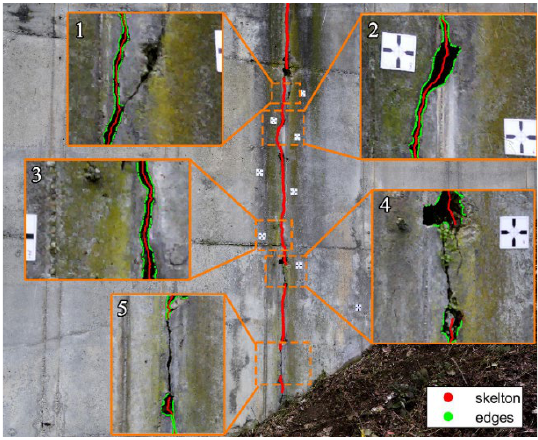
Figure 12 . Crack skeleton pixel chain (red dots) detected from image A, superimposed to the undistorted RGB image A. In the five magnified cut-outs views (1-5), the detected edges and skeleton are represented respectively with green and red